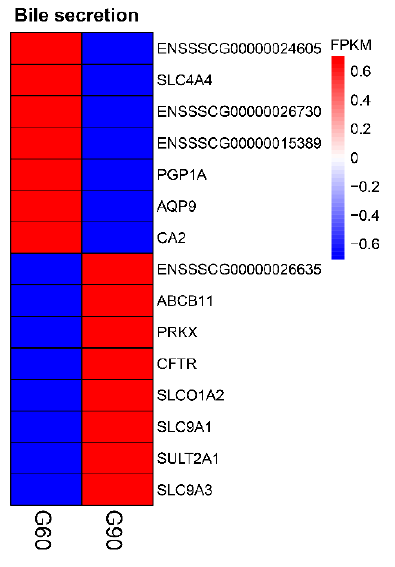
Figure 4. Unsupervised hierarchical clustering of the expression profile of significant genes enriched in bile secretion between G60 and G90 placentas.